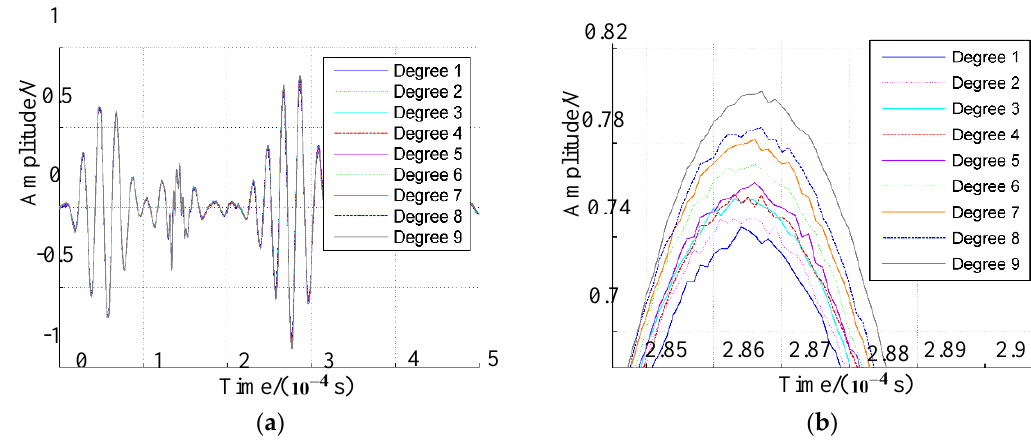
Figure 3. Lead zirconate titanate 4 (PZT4) signals in deformation experiment: ( a ) PZT4 signal when PZTA was excited; ( b ) highest wave peak.